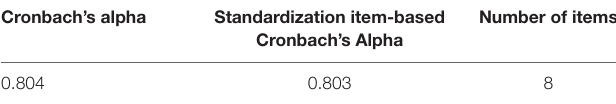
TABLE 2 | Reliability statistics.